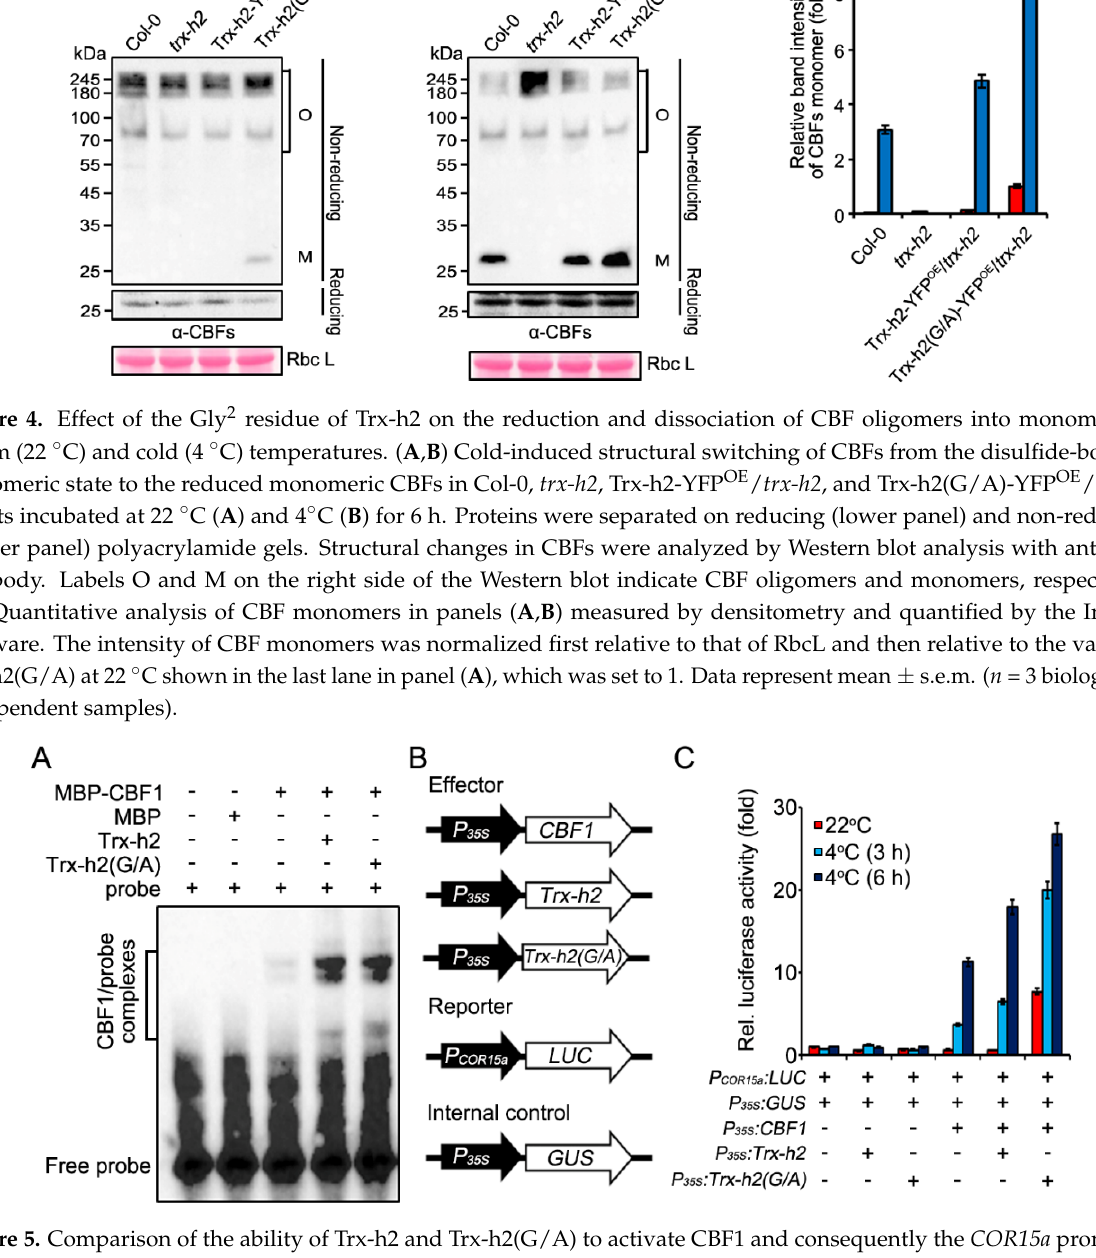
Figure 5. Comparison of the ability of Trx-h2 and Trx-h2(G/A) to activate CBF1 and consequently the COR15a promoter-driven LUC gene at different temperatures. ( A ) EMSA showing the binding of MBP-CBF1 to the biotin-labeled COR15a promoter probe in the presence of NADPH, Trx reductase, and Trx-h2 or Trx-h2(G/A). MBP was used as a negative control. Reaction products were separated on 6% polyacrylamide gels, and DNA–protein complexes were detected by Western blot analysis using anti-biotin. ( B ) Schematic representation of effector, reporter, and internal control constructs used in the LUC assay. ( C ) Quantification of LUC activity in N. benthamiana leaves co-expressing P 35S :CBF1 with P 35S : Trx-h2 or P 35S :Trx-h2(C/S) at 22 °C or 4 °C for different durations. Data represent mean ± s.e.m. ( n = 3 biologically independent samples).